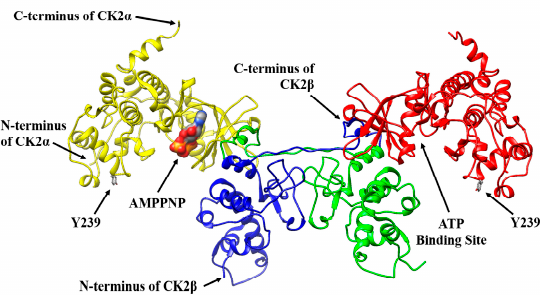
Figure 2. Ribbon diagram illustrating the structure of heterotetrameric human protein kinase CK2.